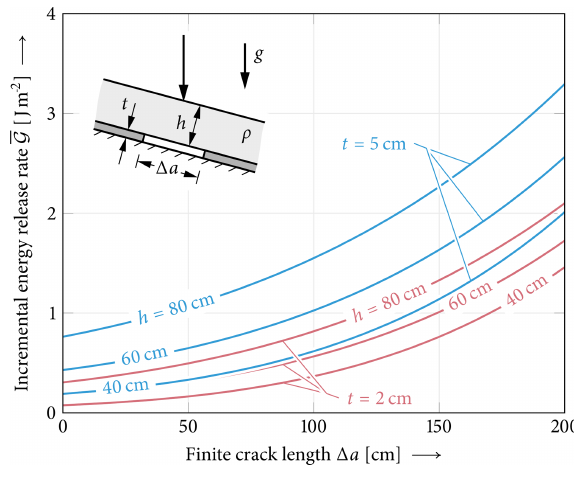
Figure 15. Incremental energy release rate of cracks below a skier for three different slab thicknesses. The slab is locally loaded by a skier and by the weight load of the slab. The slab is modeled to have a length of 25 times the slab thickness, guaranteeing vanishing boundary effects. Model parameters other than E weak = 0 . 15MPa and t = 5cm are chosen as given in Fig.